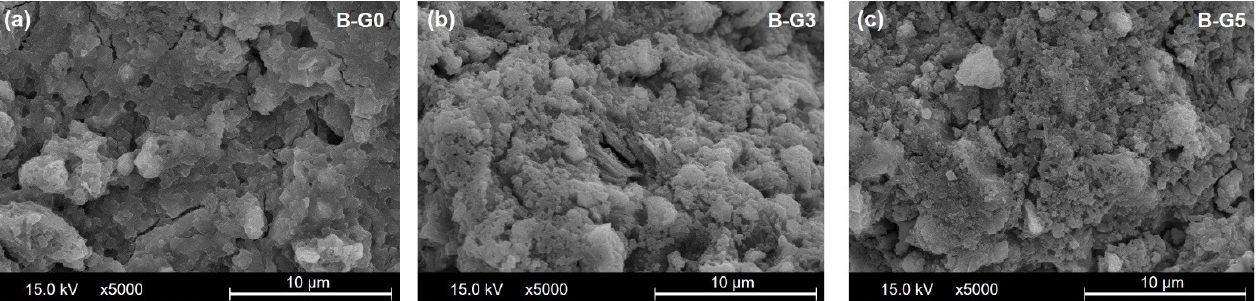
Figure 12. Microstructure of samples measured at 24 h by SEM in SE image mode. ( a ) B-G0 (no gypsum addition); ( b ) B-G3 (addition of 3% gypsum); ( c ) B-G5 (addition of 5% gypsum).